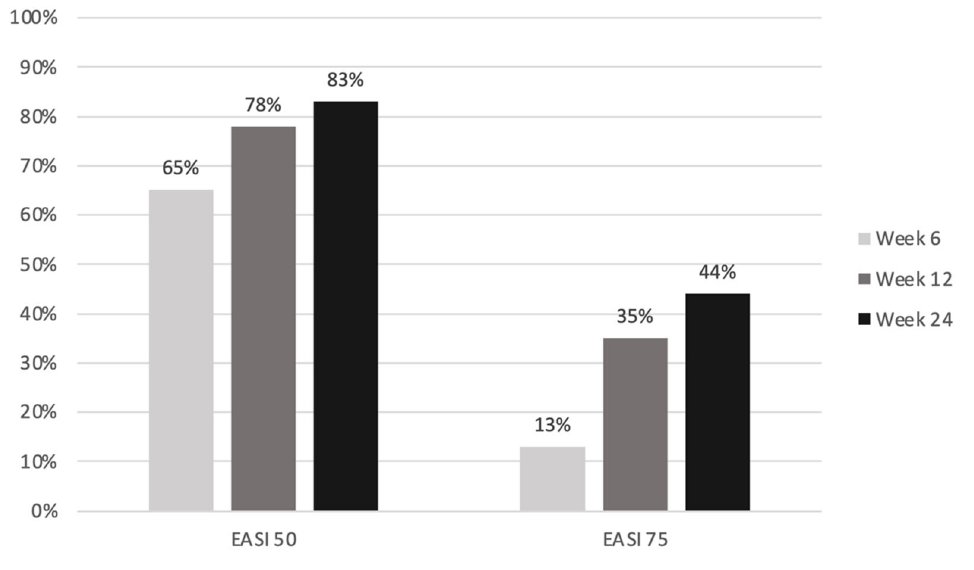
Figure 2. Percentage of patients with a 50% (EASI 50) or 75% (EASI 75) improvement in EASI.